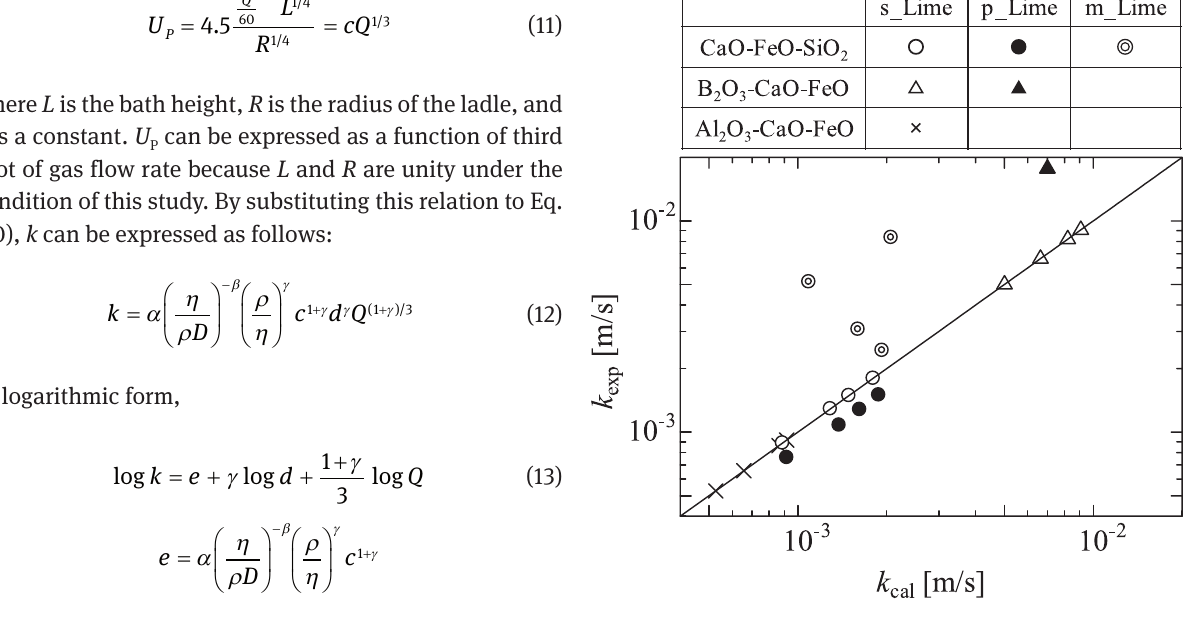
comparison of experimental k and calculated k . The line in this figure means k is equal to k . It is fairly obvious exp cal that k of s-Lime are same as k because k of s-Lime cal exp cal were analyzed by using k of s-Lime. k of p-Lime for exp exp CaO-FeO-SiO slag is lower than k . On the other hand, 2 cal k of m-Lime for CaO-FeO-SiO slag and p-Lime for B O - exp 2 2 3 CaO-FeO slag are larger than k . These results indicate cal that the effect of porosity on the dissolution of solid oxide into the slag is different irrespective of the formation of the layer. Moreover, k of m-Lime was scattered. This exp result indicates that k of m-Lime is not determined by not only the shape and physical properties of m-Lime, but also chemical property of m-Lime which is the gas forma- tion ability due to the thermal decomposition. If 2 mass% of CO remains in the m-Lime, 10.2 NmL of 2 CO /g-m-Lime was generated from m-Lime by thermal 2 decomposition of CaCO . An average weight of one piece 3 of m-Lime used in this study was 3.5 g. Thus, 200 mL of CO was generated from 1 piece of m-Lime at experimental 2 temperature. It is considered that the formed CO is more 2 effective than the bubbling/injecting gas, because CO 2 forms from inside of m-Lime. The gas formation is caused by two steps. The Gibbs free energy of formation as a function of temperature is shown in Fig. 21, which indicates that the thermal decom- position of Ca(OH) and CaCO are occurred at 790 K and 2 3 1159 K, respectively. First one is caused by the thermal decomposition of Ca(OH) , which is formed by reacting 2 with H O in air during storage. Second one is caused by Fig. 19: Relation between log k and log Q . 2